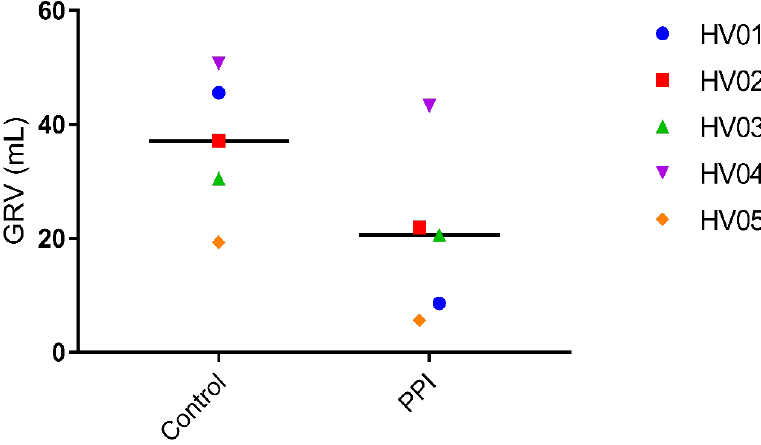
Figure 5. Gastric residual volume (GRV) in control (left) and PPI (right) condition, in five human volunteers (HV); the line depicts the median.